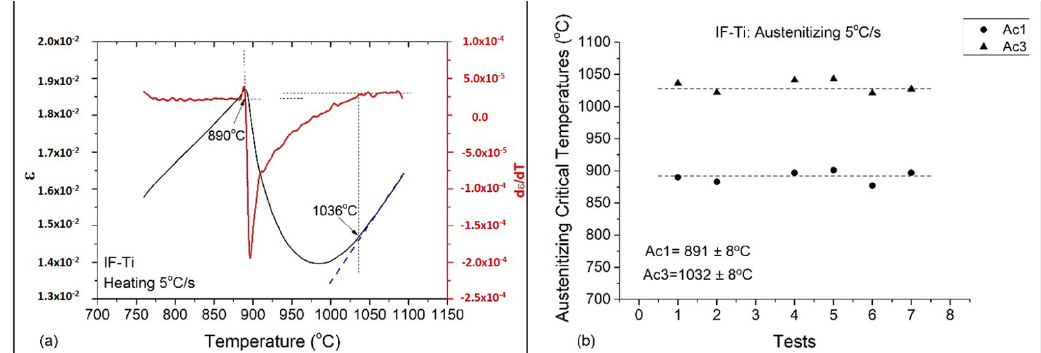
and Ac critical temperatures 1 3